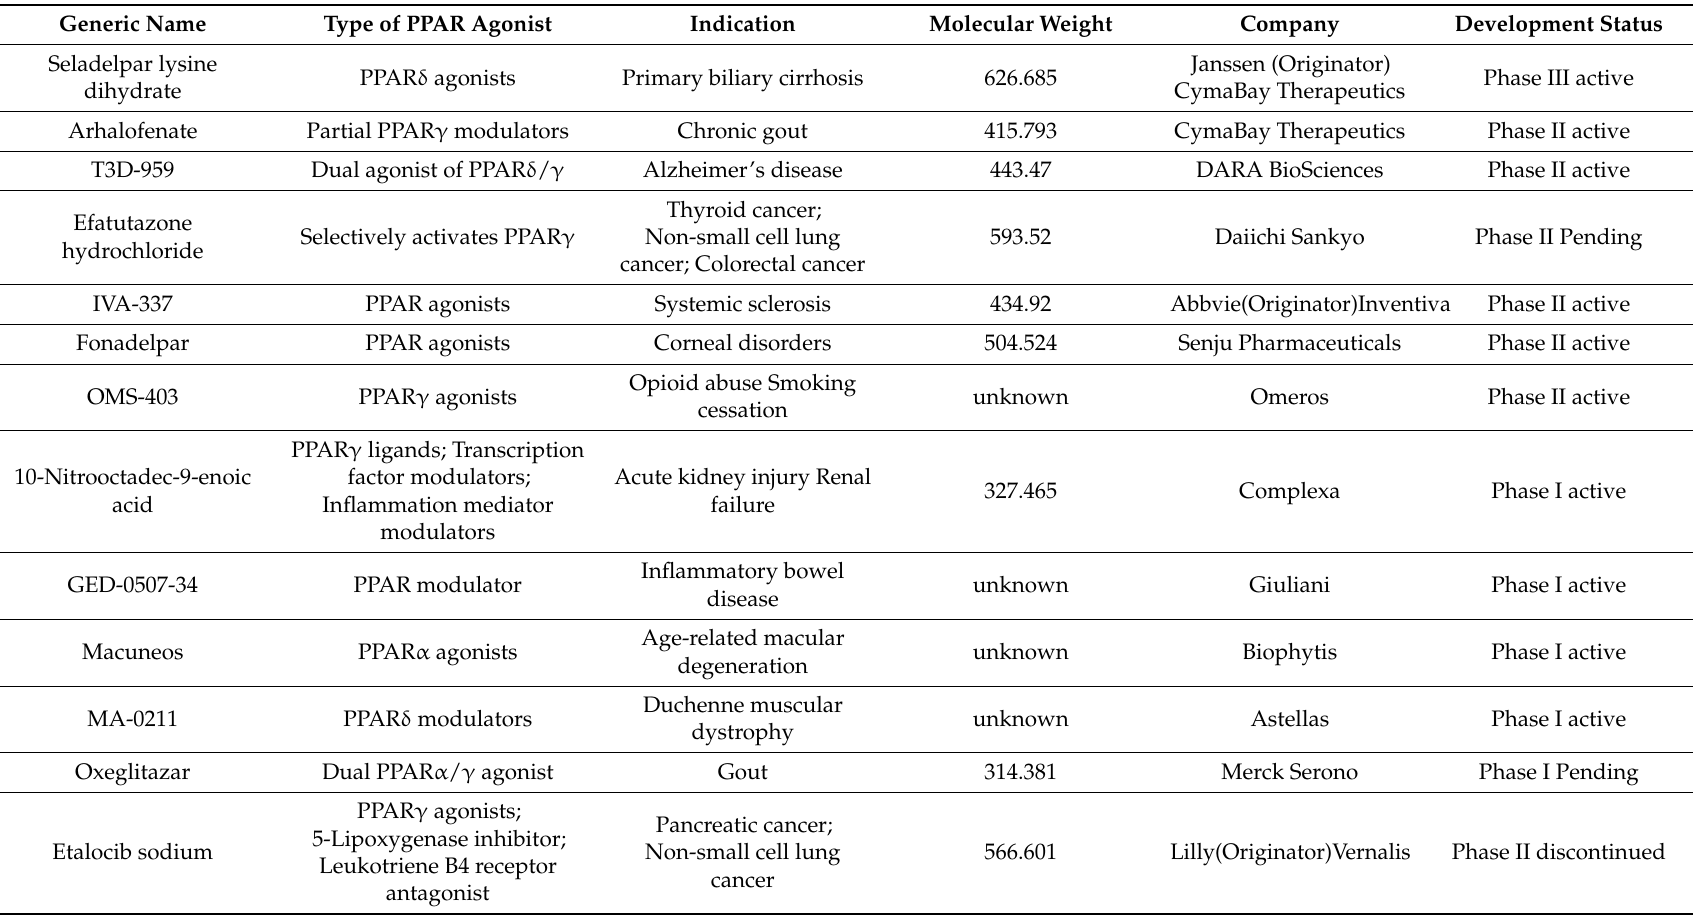
Table 12. Drugs of PPAR ligands for treatment of other diseases in clinical